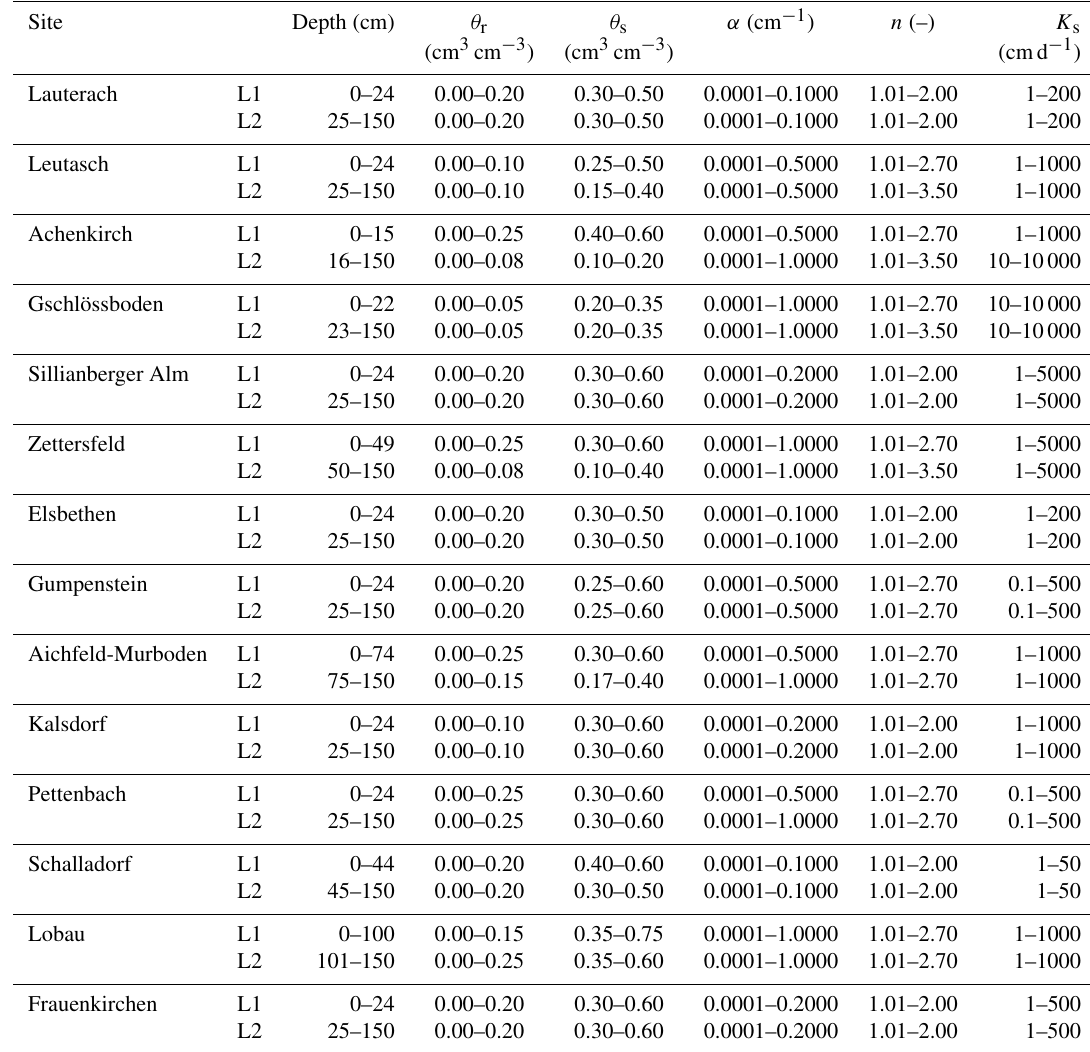
Table A3. The soil layers in HYDRUS-1D and the prior parameter ranges of the Bayesian analysis.